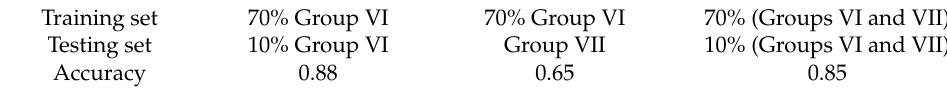
Table 13. Accuracy results of Groups VI and